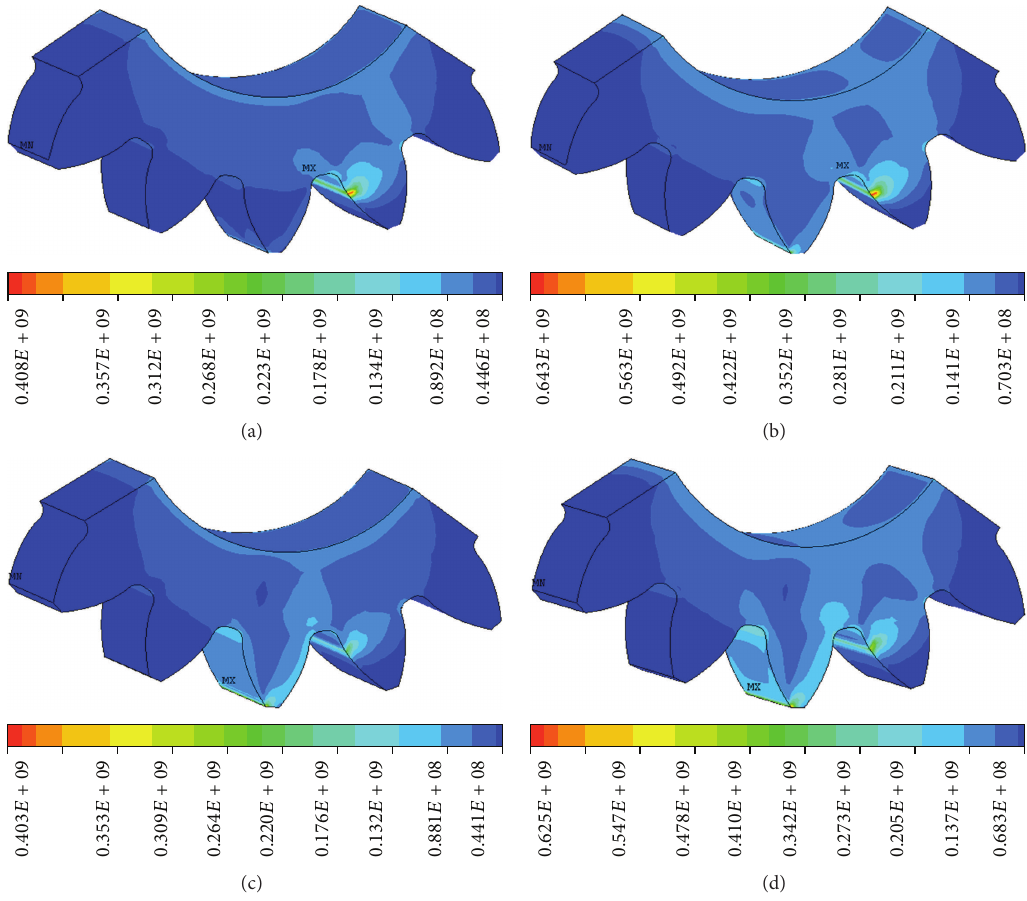
Figure 4: Static effective stress comparison of the rated conditions (a) and (c) before gear modification and the limit load conditions (b) and (d) after gear modification based on